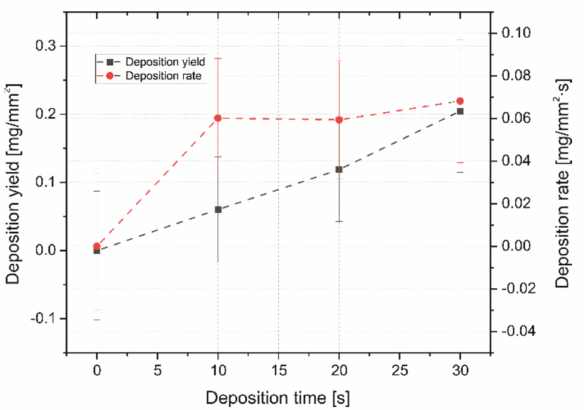
Figure 6. The changes in the deposition yield and the deposition rate with respect to deposition time at a constant voltage of 90 V.